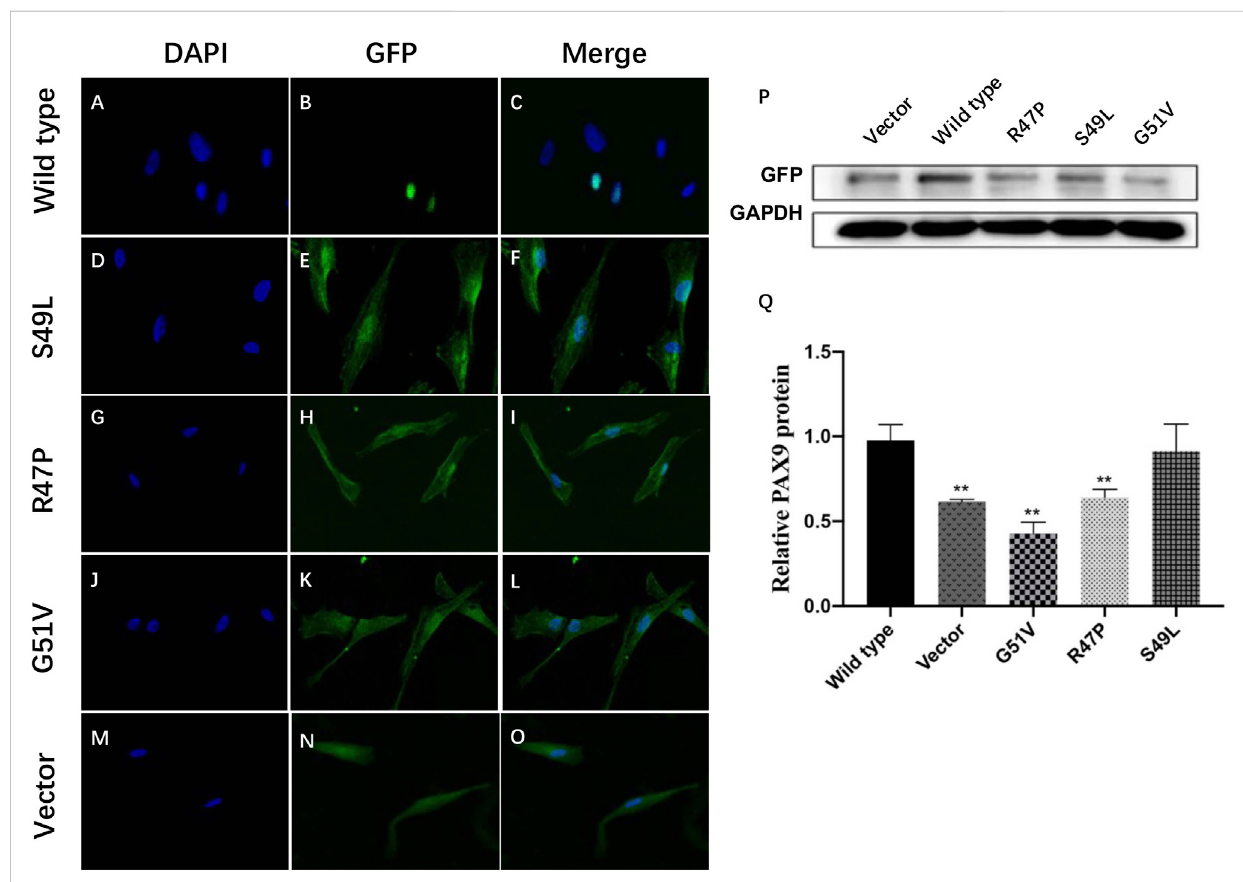
FIGURE 4 Functional studies of wild-type and variant PAX9 proteins. (A – O) subcellular localization of wild-type and variant PAX9 proteins evaluated by immuno fl uorescence assay. (P, Q) Whole-cell expression of wild-type and variant PAX9 proteins detected by Western Blotting ** p <